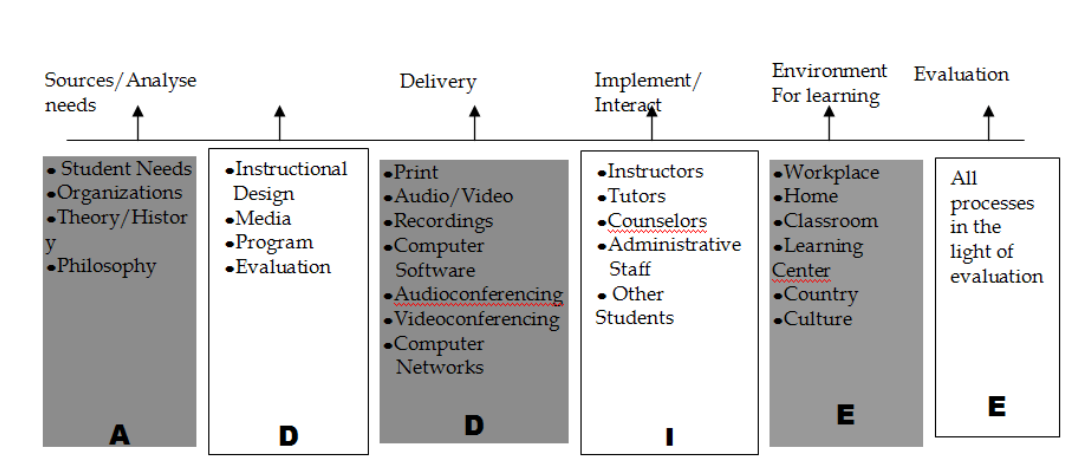
Figure 3. Moore and Kearsley’s Systems Model of Distance Education Model